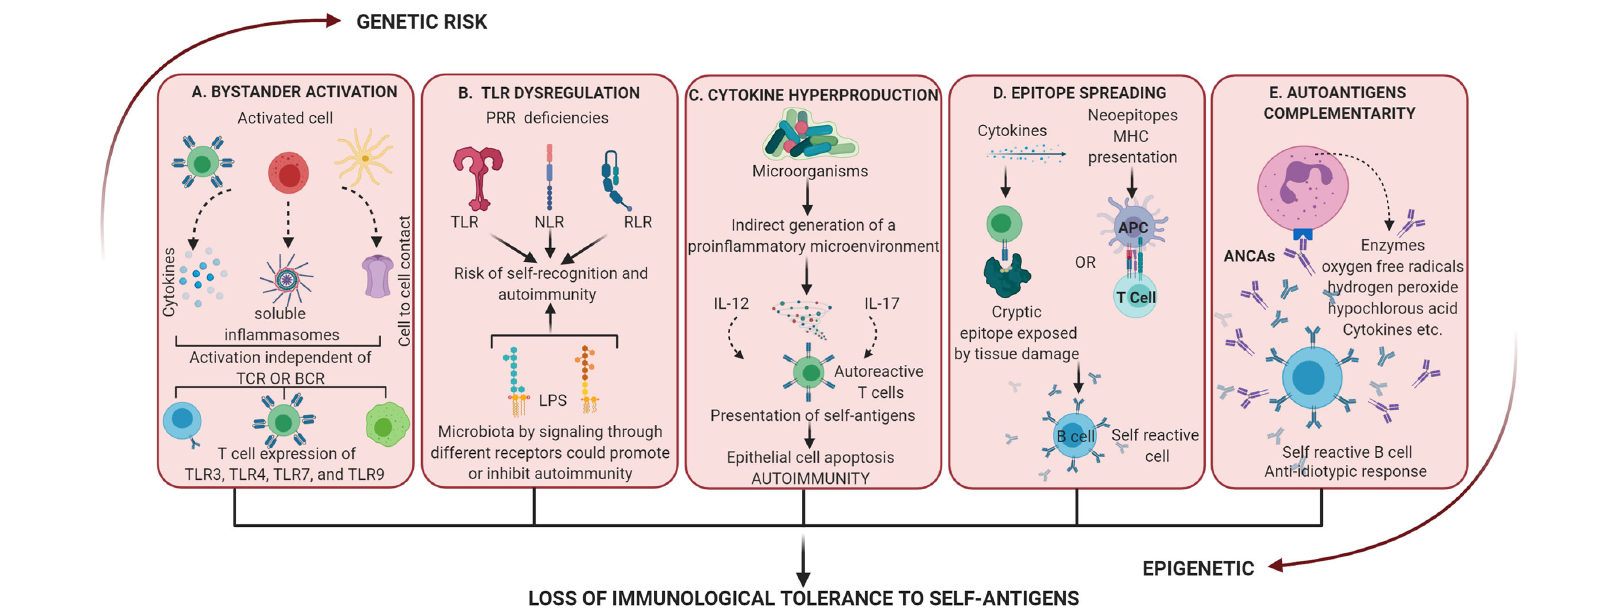
FIGURE 3 | Dysregulation of the activation of in fl ammatory processes mediated by a dysbiotic microbiota. These mechanisms alone or together lead to the loss of immunological tolerance to self-antigens. (A) Bystander activation: an “ infected ” cell can activate neighboring uninfected cells by cytokine release, the generation of soluble in fl ammasomes by macrophages, or by cell-cell contact via GAP junctions. Bystander activation can induce non-classical activation patterns such as T helper cell-dependent in fl ammation through TLRs. (B) Dysregulation of TLR: these receptors have evolved to sense nucleic acids which comes with the risk of self-recognition and autoimmunity. At the same time different LPS could promote or inhibit autoimmunity by signaling through different receptors. (C) Cytokine hyperproduction: proin fl ammation activated by commensal microorganisms can increase the response of T cells to self-antigen. Also, the differentiation of self-reactive Th17 cells has been related to apoptosis of intestinal epithelial cells induced by microbial stimulation. (D) Epitope spreading: it is related to autoimmunity by 2 mechanisms, fi rst in fl ammation allows T cells to recognize cryptic epitopes and activate B cell complementarity (independent of the antigenic presentation) and second antigen processing and presentation to activate T cell which reciprocally activate B cell (no tissue damage present). (E) Autoantigens complementarity: the activation of the autoimmune response does not occur by the autoantigen but its complementary protein-peptide initiating the production of antibodies which activate an anti-antibody response (anti-idiotypic response). ANCAs is an example of autoantibodies generated by these mechanisms and activation of PMNn produces enzymatic and proin fl ammatory products that result in dysregulation and tissue